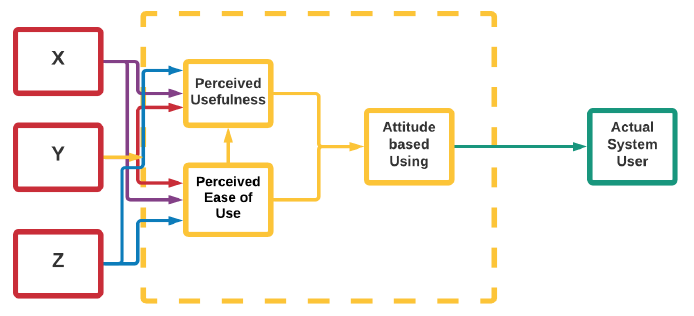
Fig. 1. Teaching Acceptance Model (TAM) (Davis,